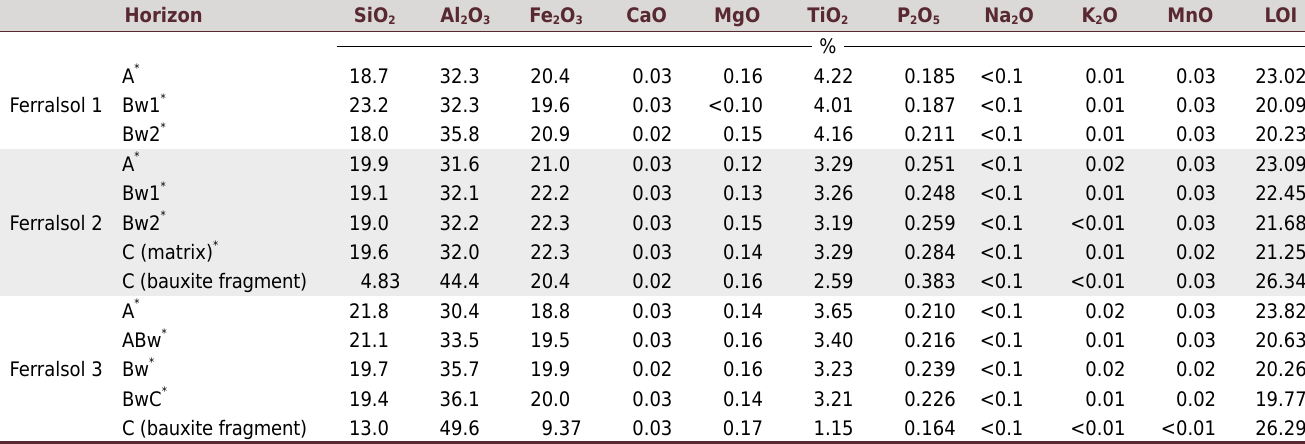
Table 4. Total chemical composition obtained by XRF, expressed in percentage of oxides, of the three studied profiles (Ferralsols 1, 2, and 3)